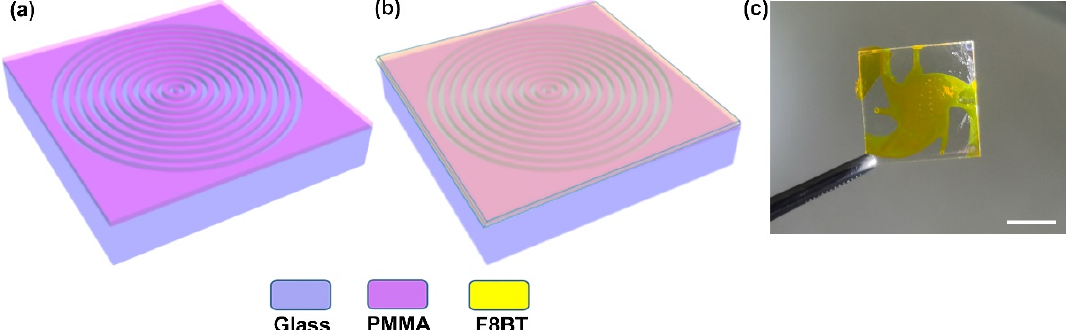
Figure 1. Schematic layout of the fabrication process. ( a ) The schematic layout of the circular periodic nanostructures written with the electron beam lithography (EBL). The blue-violet and purple color showing the glass substrate and electron beam resist PMMA film, respectively. ( b ) The schematic illustration of the gain material F8BT on the circular periodic geometry. The yellow color defines a gain medium F8BT film in the schematic layout. ( c ) The photograph of the actual composite; the scale bar is 1 cm.